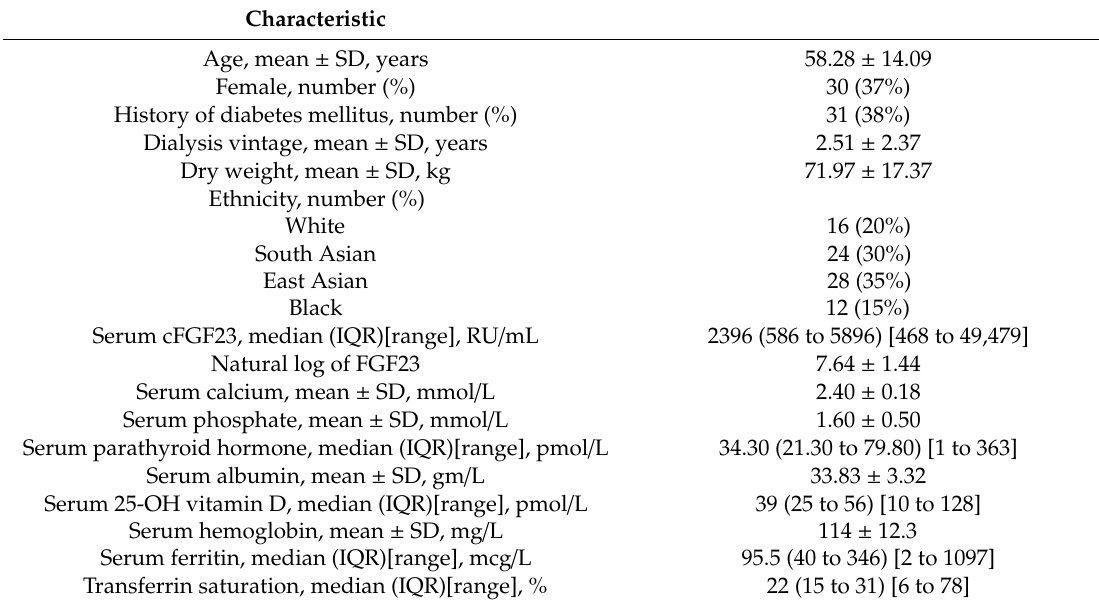
Table 1. Baseline